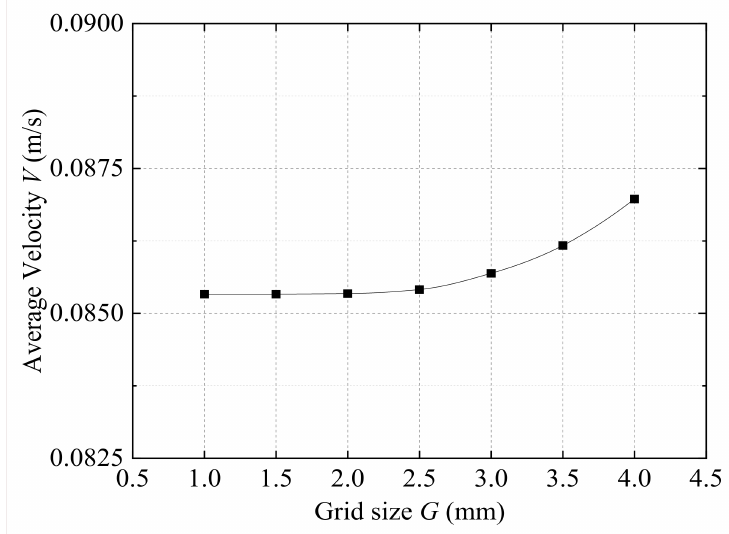
Figure 2. The average velocity of the cross-section in the jet.